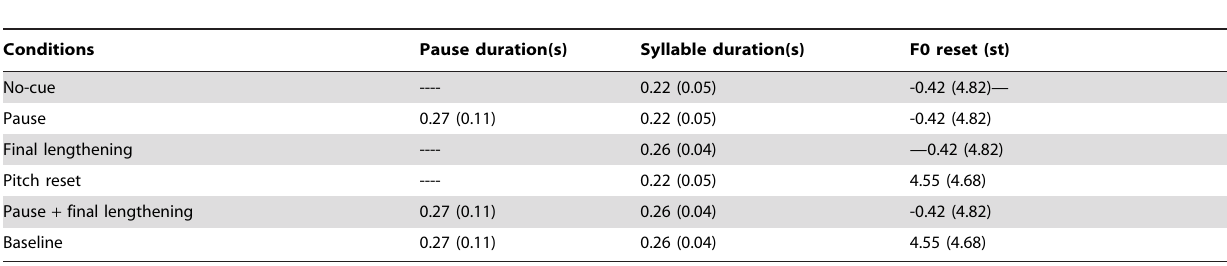
Table 1. Means of the acoustic parameters for the six conditions (with standard deviations in